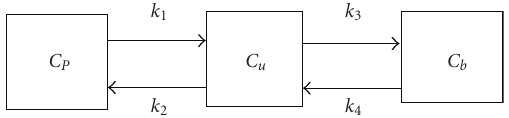
Figure 1: Three compartments used to model the transfer of the tracer between physical compartments and chemical